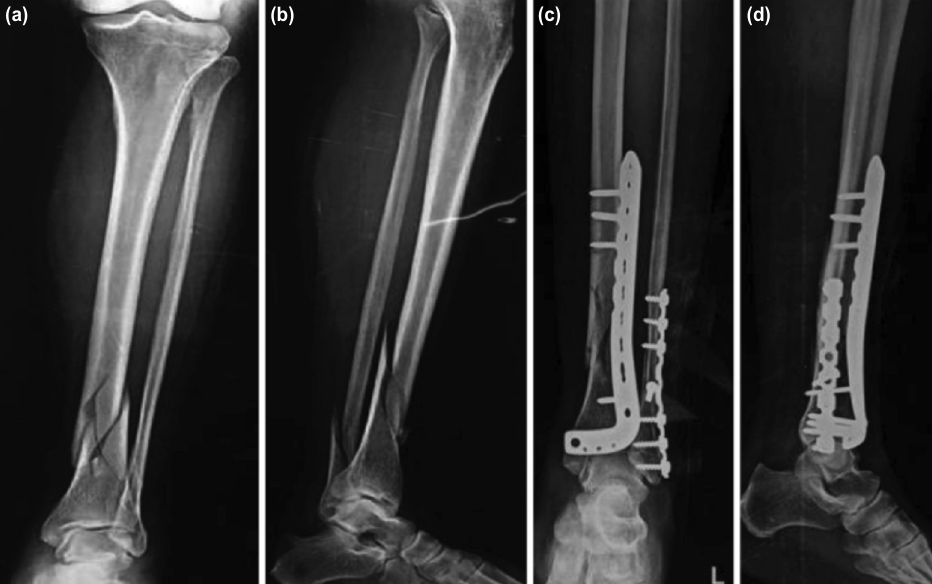
Pre-operative radiographs of extra-articular distal tibia fracture AO Type 43-B3 showing (a) antero-posterior and (b) lateral view. Fig. 2: Immediate post radiographs showing ORIF with plating done in (c) antero-posterior and (d) lateral